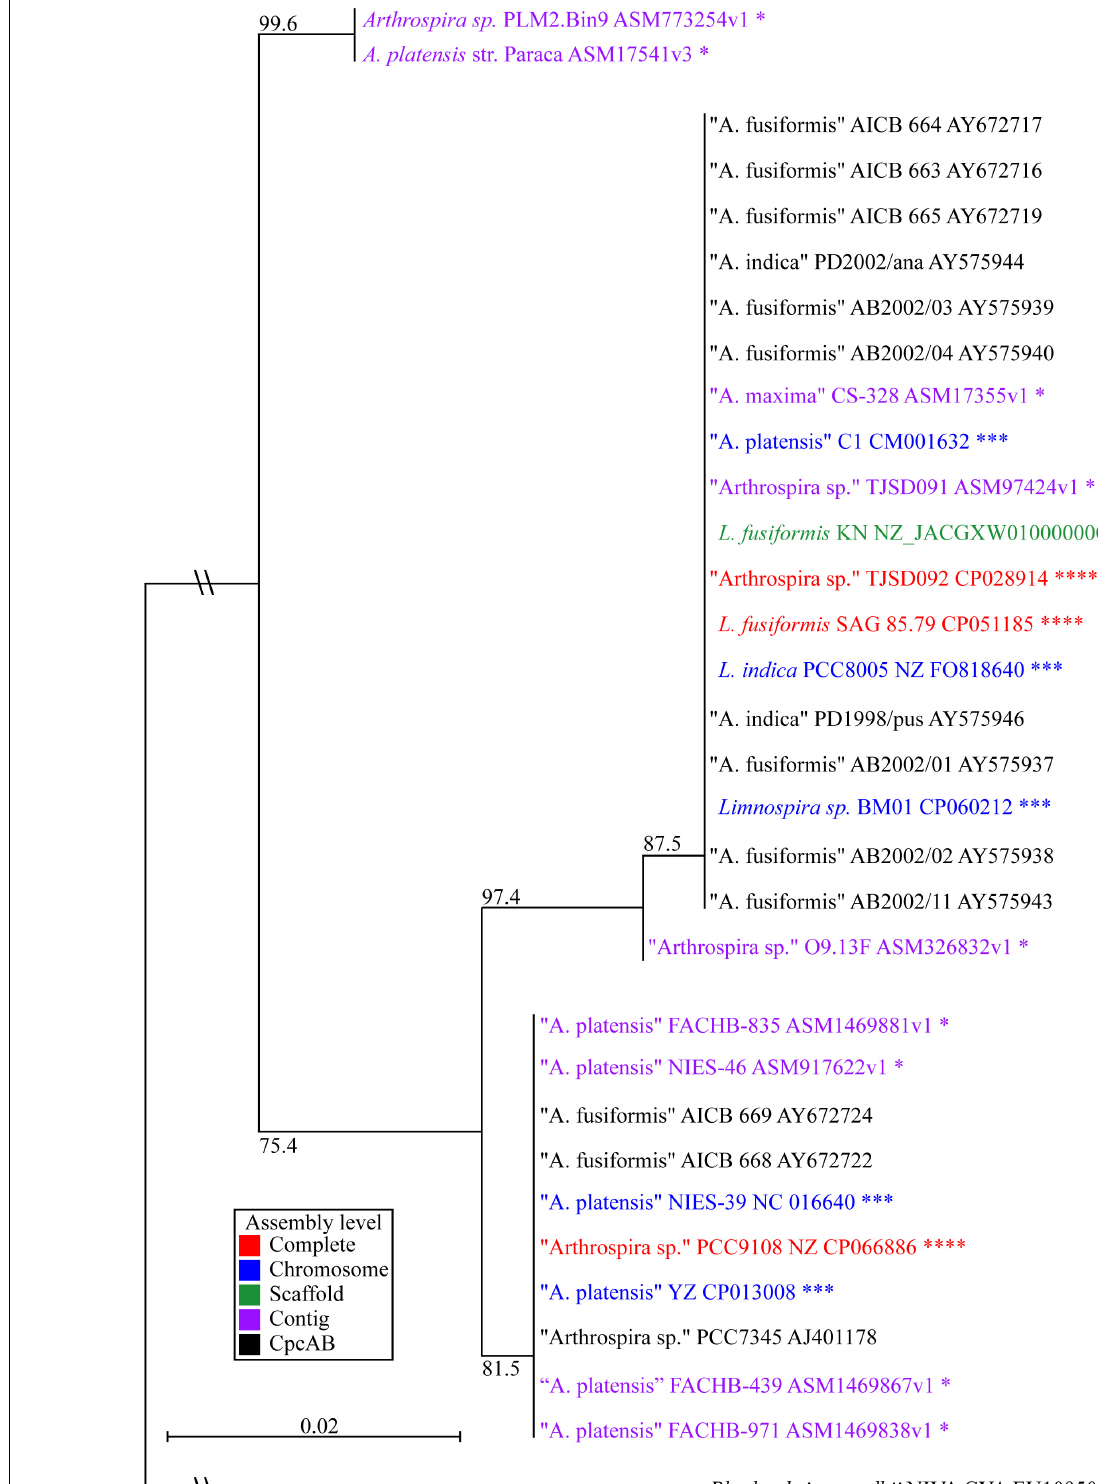
FIGURE 3 | Limnospira phylogenetic tree based on cpcAB loci. The sequence sources of the cpcAB loci are denoted: complete genome (red ∗∗∗∗ ), chromosome assembly (blue ∗∗∗ ), scaffold assembly (green ∗∗ ), contig assembly (purple ∗ ), cpcAB sequence only (black). Bootstrap values of major branch points are shown. Quotation marks are used to indicate species proposed for Limnospira